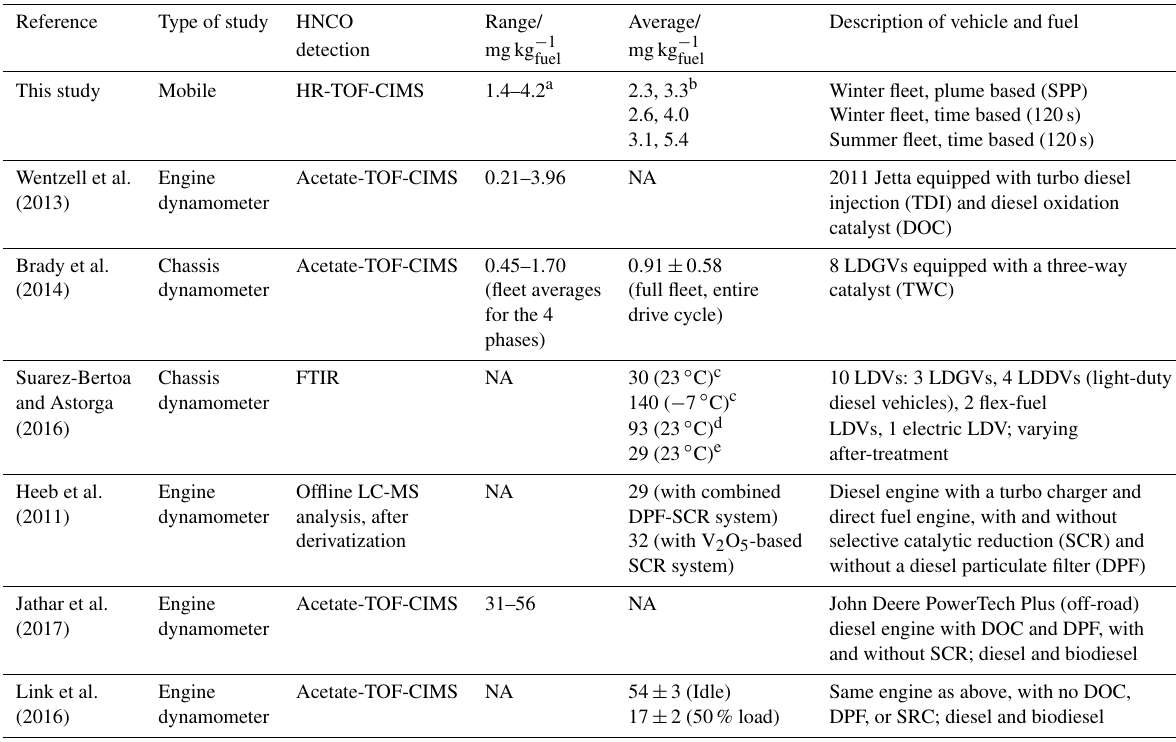
Table 3. Comparison of literature HNCO emission factors from the exhaust of various gasoline- and diesel-fueled engines in fuel-based units (mgkg − 1 fuel